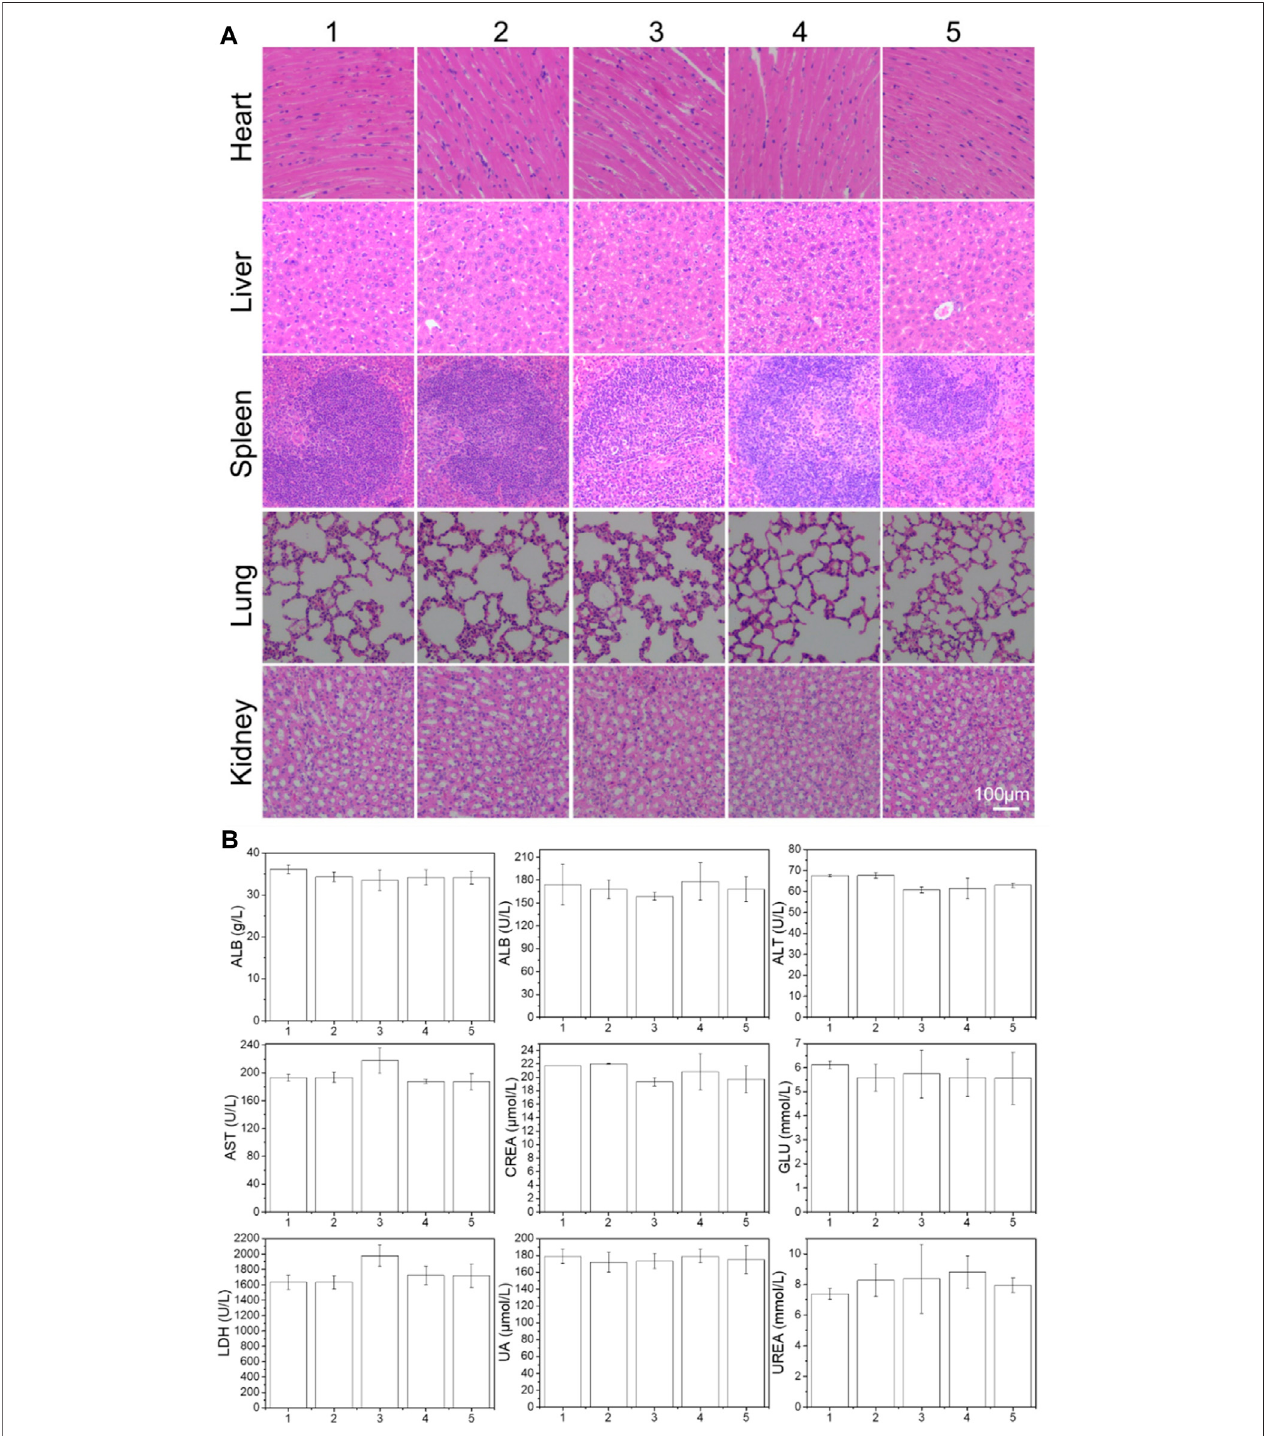
FIGURE 6| (A) Histologic assessments ofmajor organs in mice (200 × ) treated with different formulations. (B) Serum levels ofalbumin (ALB), alkalinephosphatase (ALP), alanine aminotransferase (ALT), aspartate aminotransferase (AST), lactate dehydrogenase (LDH), glucose (GLU), creatinine (CREA), uric acid (UA), and urea (UREA) of mice after 21 days treatment of different formulations. (1: PBS; 2: PLA-PEG-T7; 3: TMZ; 4: PLA-PEG/TMZ/TPE; 5: PLA-PEG-T7/TMZ/TPE).